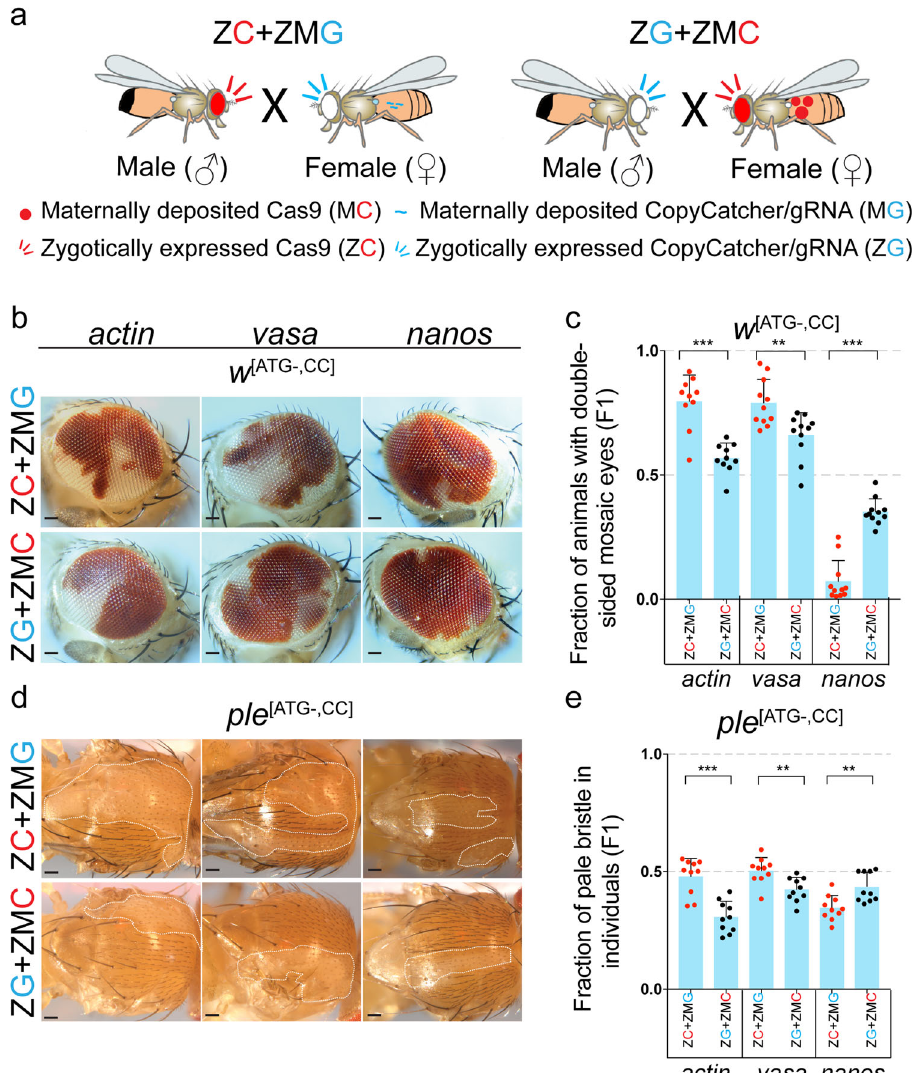
Fig. 2 Highly ef fi cient gene conversion in somatic cells revealed by using the CopyCatcher system. a Paternal and maternal crossing schemes using either F 0 males or females carrying Cas9 transgenes inserted in the yellow locus expressed by different promoters and marked with 3XP3 - DsRed (in the eye). Trans-heterozygous F 1 females obtained in both crosses carrying both CopyCatcher elements inserted into the white ( w ) or pale ( ple ) loci and static Cas9 expression cassettes were used to score SGC. b , d Examples of mosaic phenotypes ( n = 15 biological independent fl ies were observed) of the F 1 trans-heterozygous y + , w [ATG-,CC] / y [Cas9] , w + compound eyes ( b ) or y [Cas9] / + ; ple [ATG-,CC] / + thorax bristles ( d ). Clones of pale bristles delineated by dotted white lines in ( d ) denote the patches created by SGC events. c , e SGC rates measured by the fraction of F 1 female progeny having double-sided mosaic eyes ( c ), or the fraction of pale thorax bristles relative to the total thorax bristles in individual F 1 trans-heterozygous females ( e ). Each dot in ( c ) represents SGC averages from single vials ( n = 10 biological independent crosses for actin promoter-driven Cas9, and n = 11 biological independent crosses for both vasa and nanos promoter-driven Cas9) and in ( e ) represents the percent of pale bristles for an individual fl y (as shown in panel ( d ), n = 10 biological independent fl ies). ZC + ZMG: Cas9 males crossed with CopyCatcher females, ZG + ZMC: CopyCatcher males crossed with Cas9 females. Error bars indicate mean values± SD. Asterisks represent signi fi cance with a two-tailed t -test: three asterisks ( p < 0.001 ), two asterisks ( p < 0.01 ), one asterisk ( p < 0.05 ), and ns (not signi fi cant). Scale bars stand for 200 pixels. Raw data for ( c ) and ( e ) are provided as Source Data fi